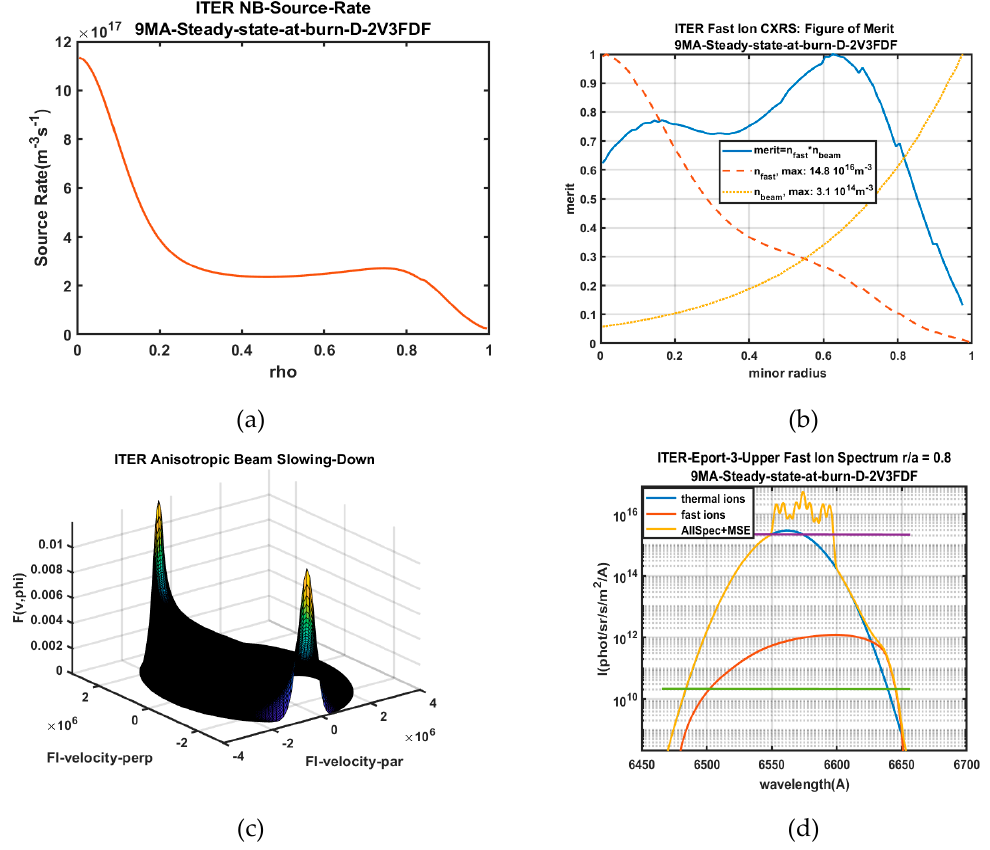
Figure 22. ( a ) ITER DNB source rate, beam power 3.6MW, energy 100 keV, Finite-Grid model for 1280 beamlets, shine through 1.5%; ( b ) FICX on beam ions (FIDA), solid line: figure-of-merit, dashed line: fast ion density profile, dotted line: DNB density profile. All signals shown are normalized by their respective maxima. ( c ) 3-dim presentation of anisotropic beam-ion slowing-down velocity distribution function [28] versus v perp and v par respectively (parallel and perpendicular to the magnetic field). Velocities are in m/s. ( d ) SOS simulation for FICX on DNB showing thermal, MSE and slowing-down features as well as continuum and associated noise level. The FICX signal is two orders of magnitude below the thermal feature and is even at the maximum figure of merit location, r = 0.8, barely